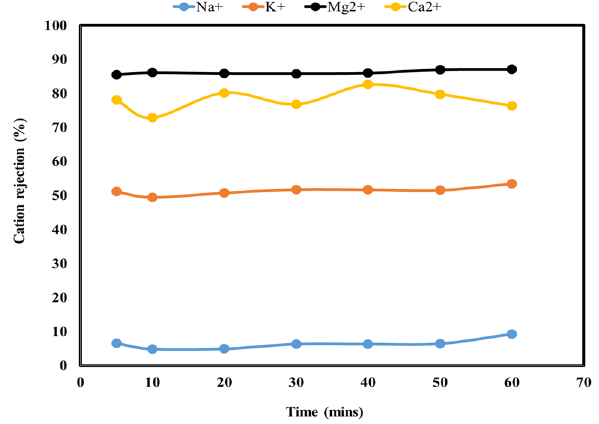
Fig. 12 Cation rejection of modified filter cake containing pure ben- tonite and activated clay